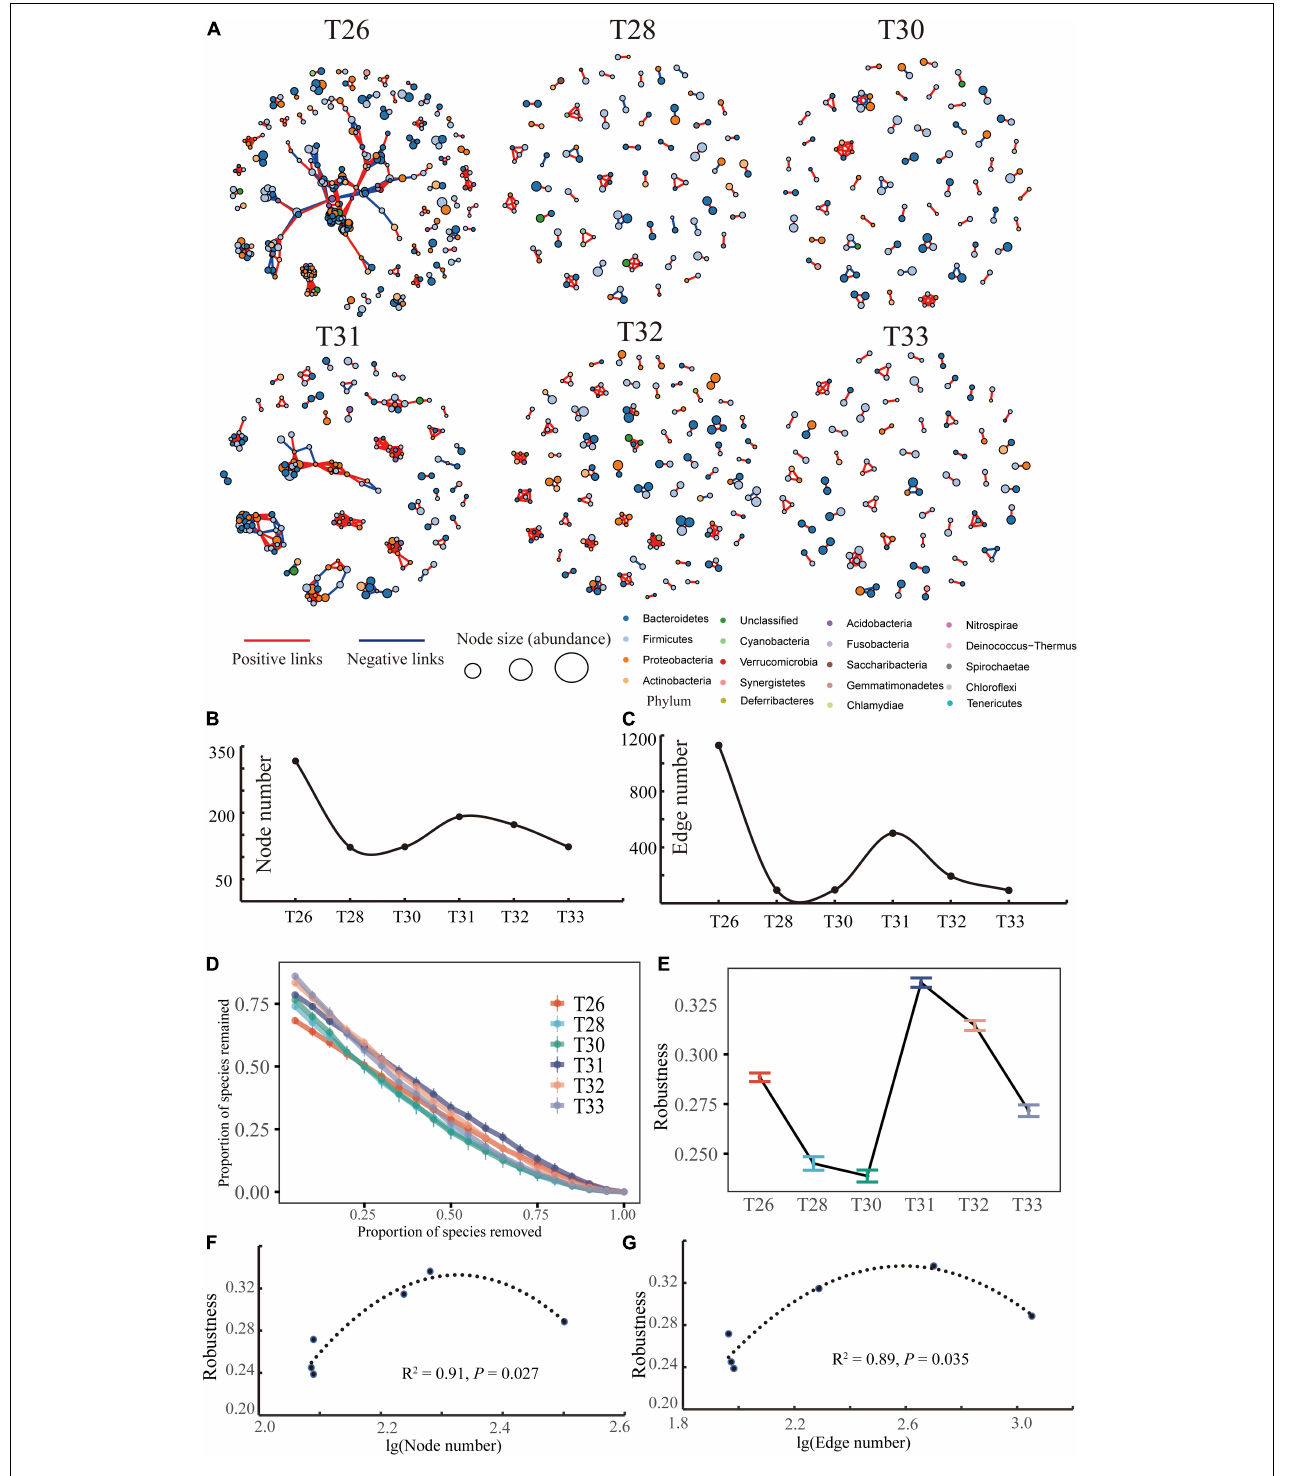
FIGURE 7 | Co-occurrence patterns of the microbial community. (A) Microbial co-occurrence networks across the different treatments. The nodes are colored based on the phylum level for coral-associated bacteria. The size of each node is proportional to the relative abundance of OTUs; the thickness of the edge is proportional to the value of Spearman’s correlation coefficient. (B,C) Are the node number and edge number of the co-occurrence networks at the different temperatures, respectively. (D,E) Are network stability and the robustness (the proportion of taxa remained with 50% of the taxa randomly removed from each co-occurrence network) of networks under different temperature conditions. (F,G) Are the relationship between network robustness and microbial network complexity (node number and edge number).